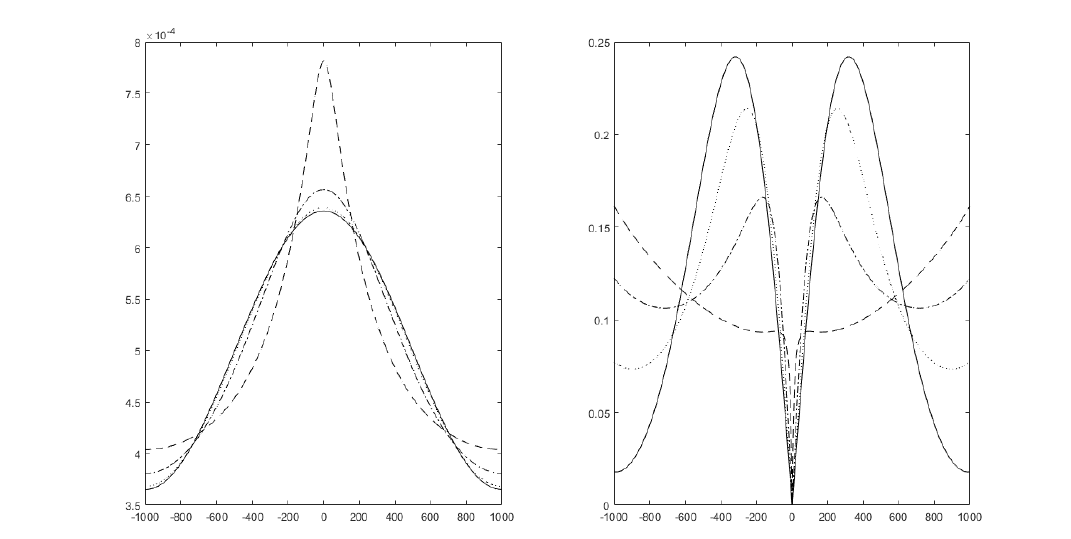
Figure 2. Left : Lévy distributions p ( x ) for γ = 2 (solid line), γ = 1.5 (dotted line), γ = 1 (dot-dashed line), and γ = 0.5 (dashed line) for c = 2; Right : Plots of associated distributions xp ( x ) for γ = 2 (solid line), γ = 1.5 (dotted line), γ = 1 (dot-dashed line) and γ = 0.5 (dashed line) for c = 1/2.